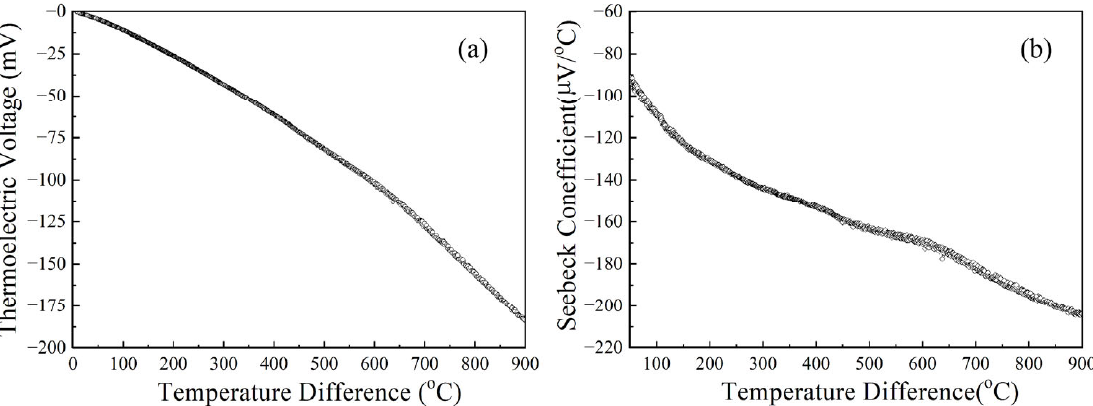
Figure 7. Thermoelectric response curve of In 2 O 3 /Pt thermocouple. ( a ) Thermal voltage output; ( b ) Seebeck coefficient.